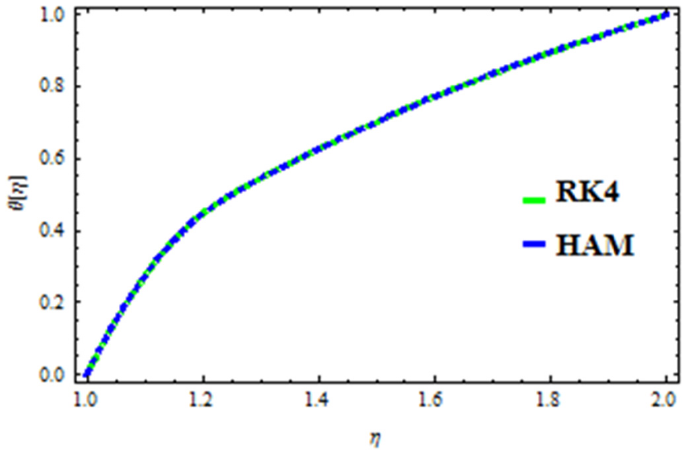
Figure 28. Comparison of RK4 and HAM for temperature in Vogel’s model. Table 1. Comparison of the present work with HAM and published works.